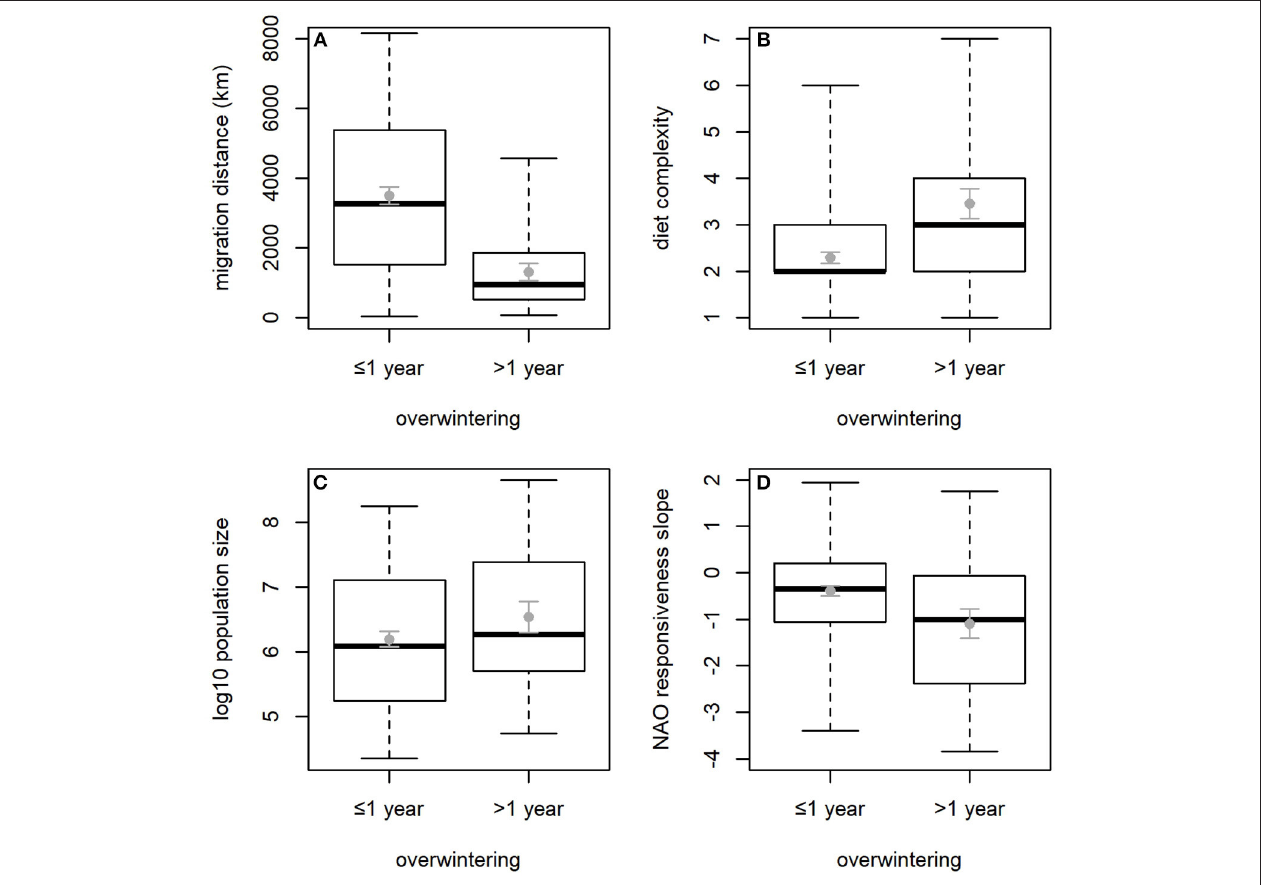
FIGURE 2 | Comparison of (A) migration distance, (B) diet complexity, (C) population size, and (D) NAO responsiveness between species that were ( N = 22) or were not ( N = 85) observed overwintering at the study site in more than 1 year from 1975 to 2006. Box plots show the median (thick middle line), interquartile range (box), and data range (whiskers); the gray error bars depict the mean ± standard error. NAO responsiveness slope has more negative values if the species had earlier arrivals after high-NAO winters.